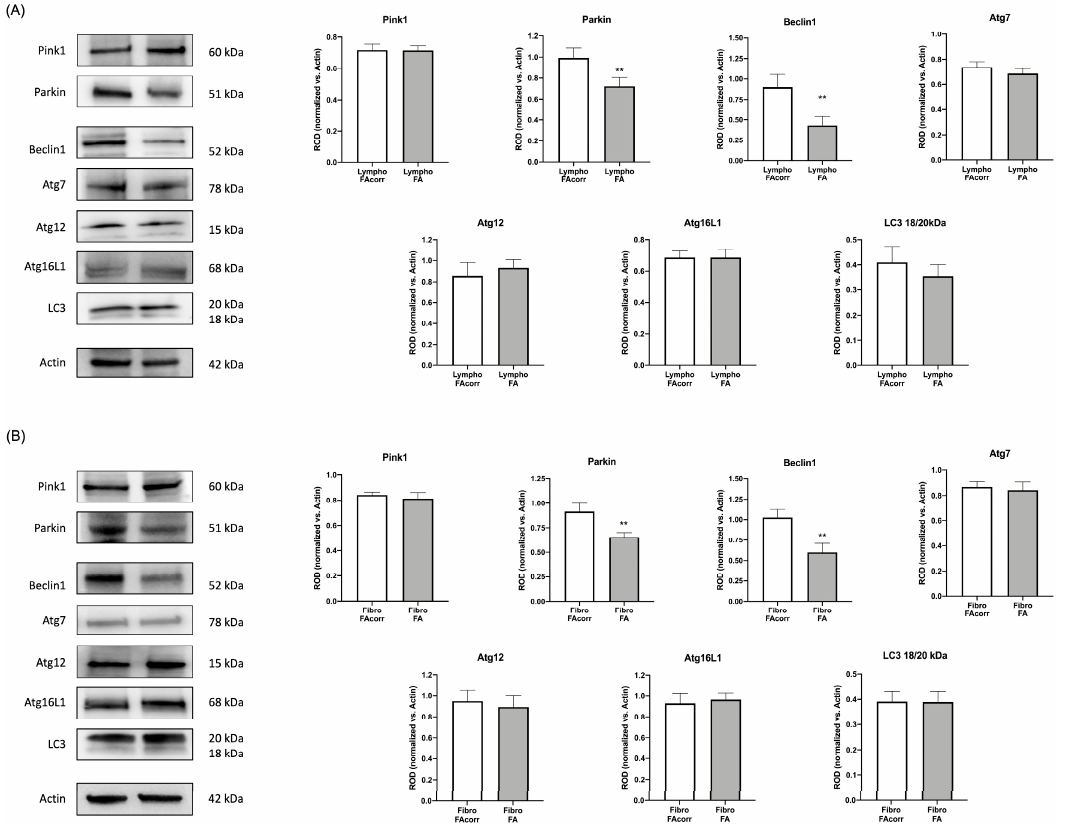
Figure 7. Expression levels of mitophagy and autophagy markers in lymphoblasts and fibroblasts mutated for the FANC-A gene. Lymphoblast ( A ) and fibroblast ( B ) cell lines expression of proteins involved in mitophagy and autophagy processes. WB signals of Pink1, Parkin, Beclin1, Atg7, Atg12, Atg16L1, and LC3. Actin signal has been used as a housekeeping signal for data normalization. The LC3 graph represents the ratio between the active (18 kDa) and inactive (20 kDa) form of the protein. Data are reported as mean ± SD. Histograms and WB signals are representative of at least three independent experiments. Statistical significance was tested with an unpaired t -test; ** represents a significant difference for p < 0.01 between FA cells and FAcorr cells used as control. 3. Discussion FANC-A mutated cells show damaged mitochondria associated with an impaired OxPhos function due to altered electron transfer between complexes I and III, confirming data reported in the literature [7,10,12,18]. This metabolic alteration causes a reduction in